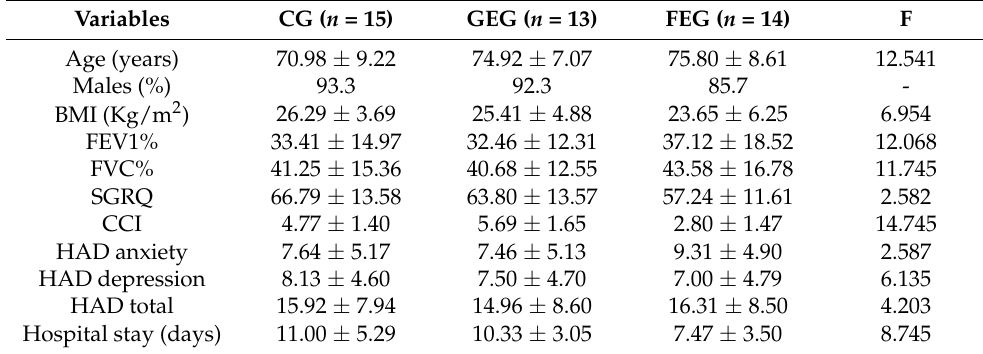
Table 1. Admission characteristics of the subjects for each group.